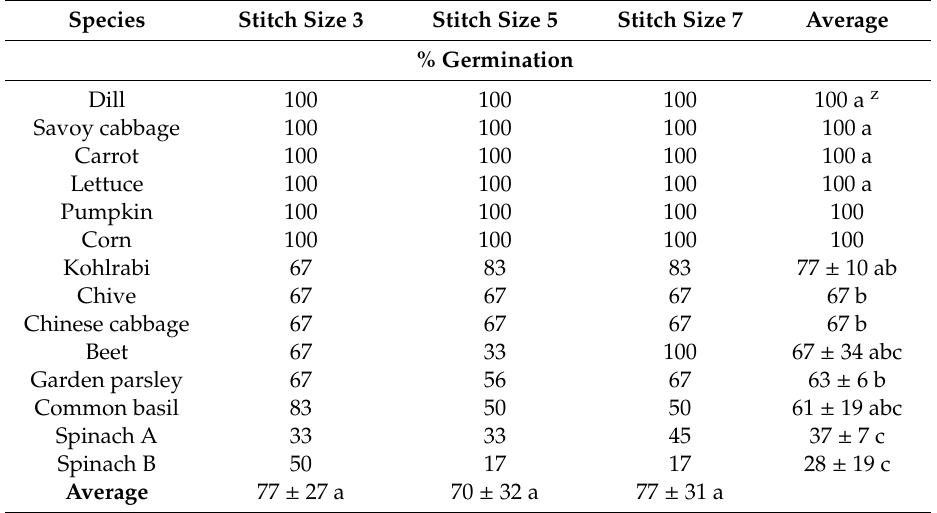
Table 3. Percentage of germinated seeds per fabric, sorted by average germination success. Species Stitch Size 3 Stitch Size 5 Stitch Size 7